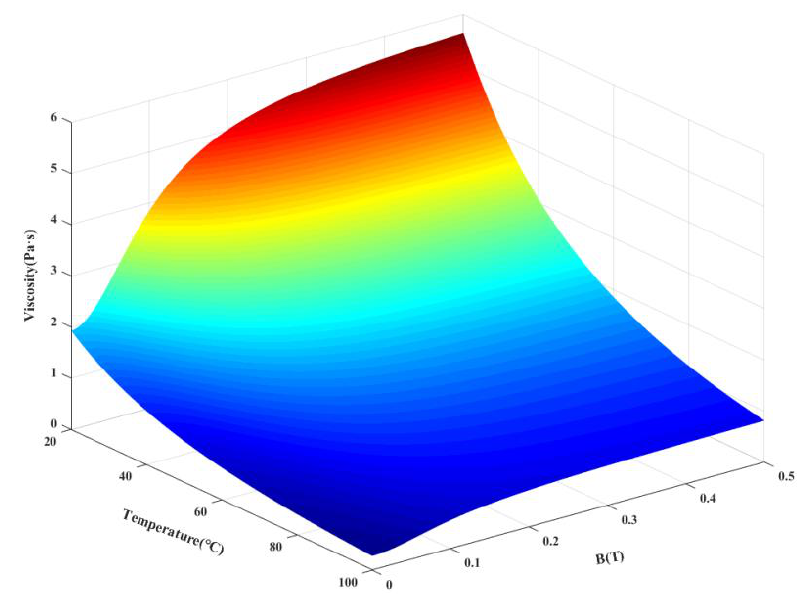
Figure 6. Magnetic adhesion properties of magnetic fluid lubrication film.